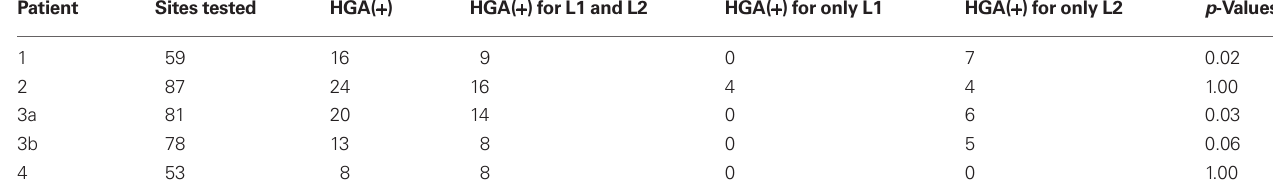
Table 3 | Electrodes (sites) with statistically significant HGA during visual object naming in first (L1) and second (L2) languages. p Values comparing number of HGA( + ) sites during L1 and L2 naming within patients using the McNemar’s test.